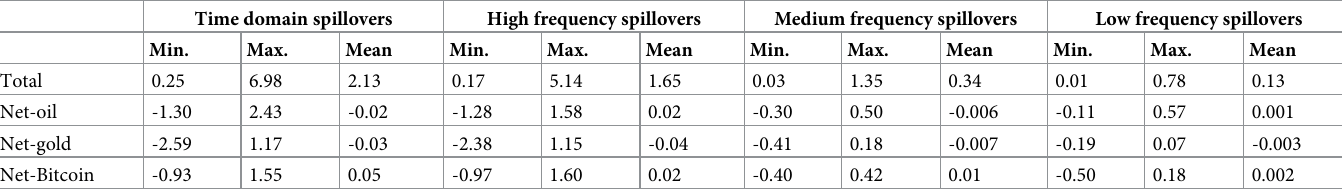
Table 2. The statistical results of time-frequency dynamics of sentiment spillovers in crude oil, gold, and Bitcoin markets. Time domain